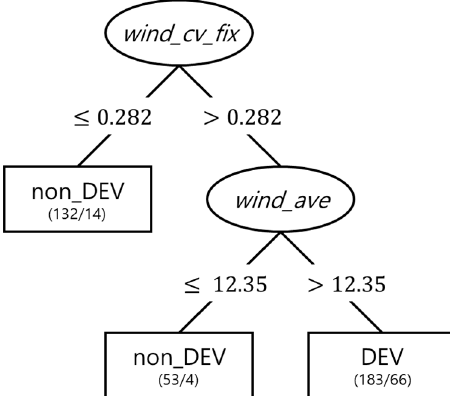
Figure 2. An example of the decision tree that classify developing (DEV) or non-DEV tropical disturbances, built by the decision trees (DT) model trained with a subset data for 2005, 2007, and 2009. The eclipses contained selected predictors and rectangles represented the number of corrected classified and misclassified sample. Two predictors—wind_cv_fix, and wind_ave—were selected from the training with the percentage value of importance 100%, and 68%, respectively.